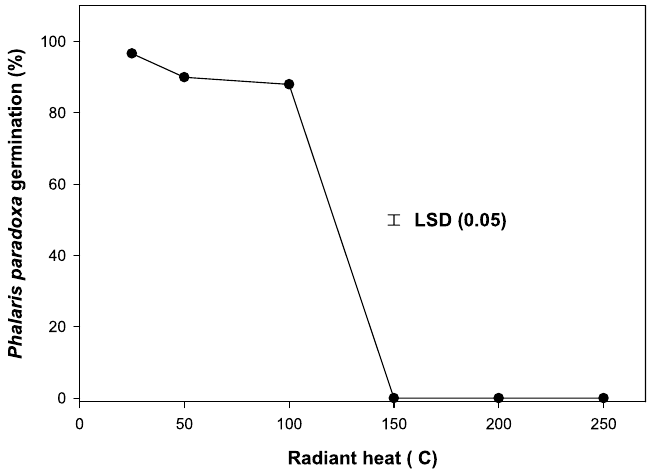
Figure 2. Effect of high-temperature pretreatment for 5 min ( ℃ ) on germination of Phalaris paradoxa seeds. LSD: Least significant difference at the 5% level of significance.